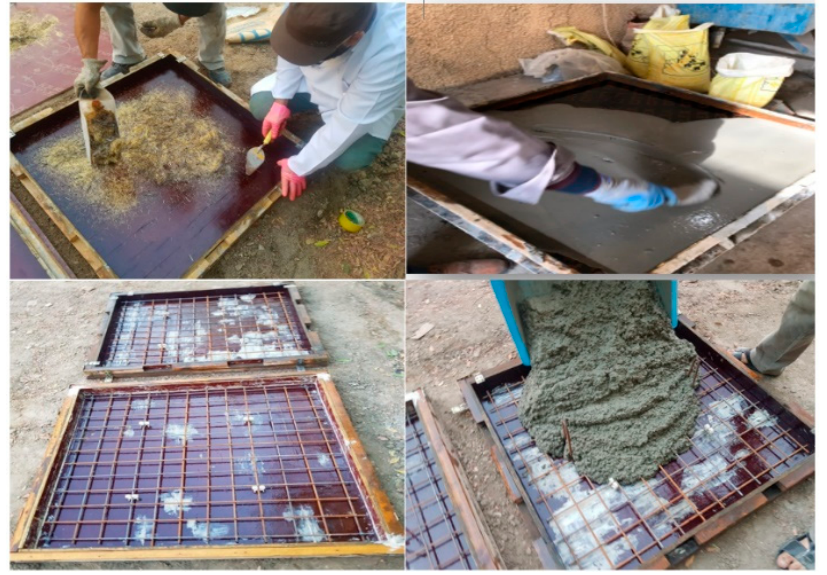
Figure 3. The casting of SIFCON and NSC slabs.